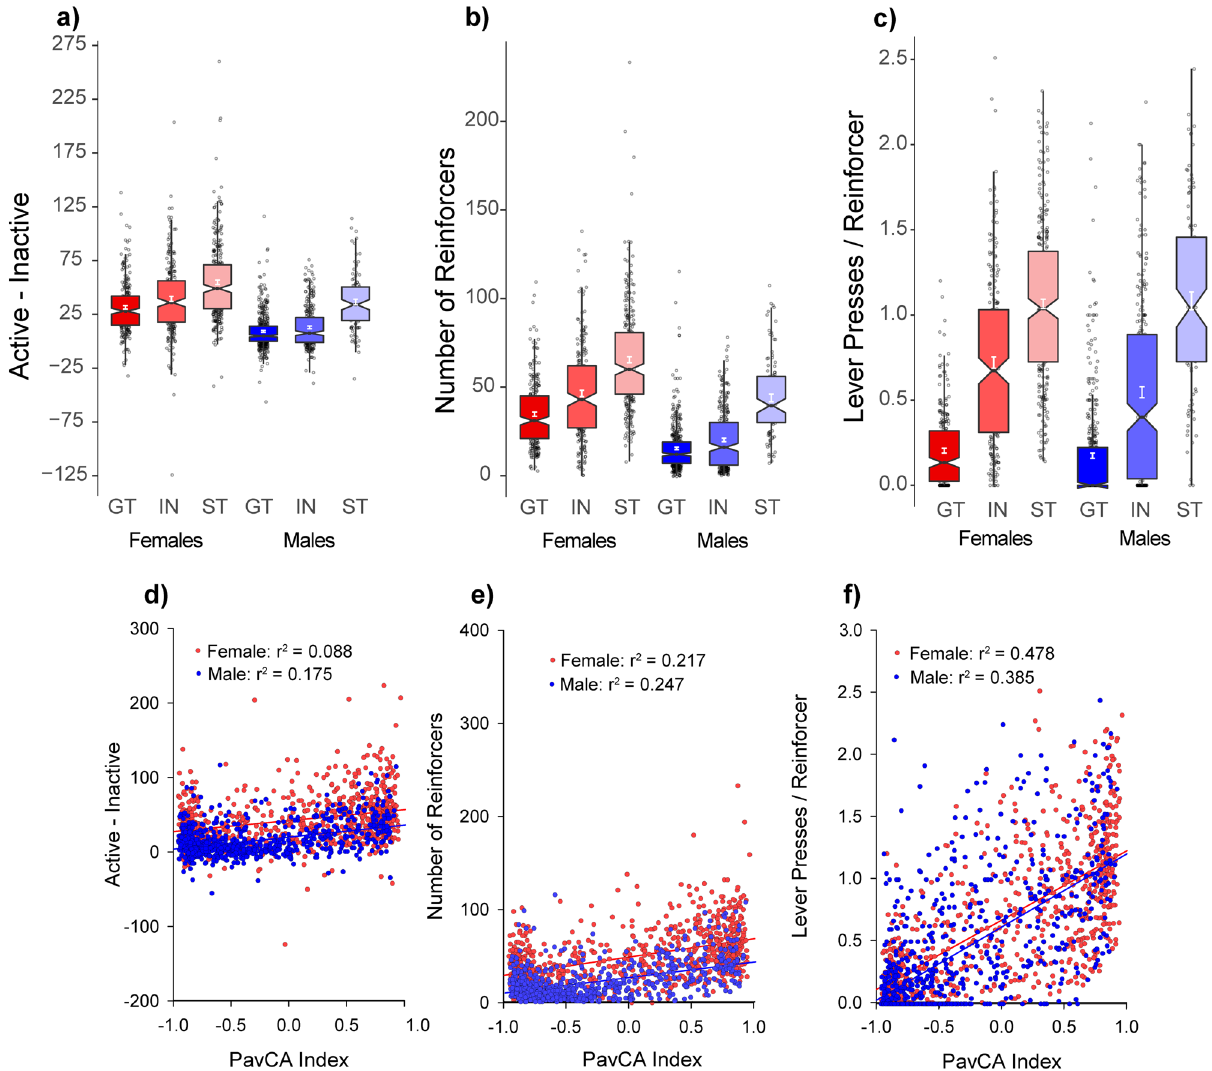
reflect sign-tracking